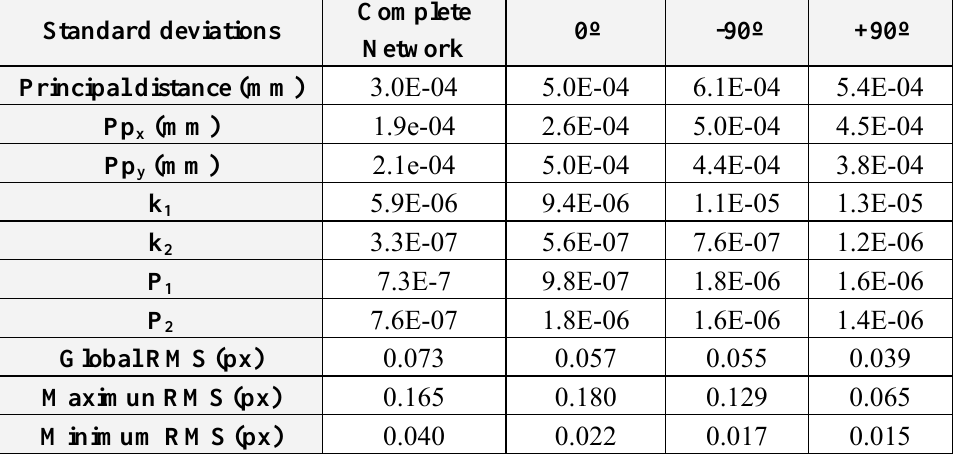
Table 7. Standard deviations obtained with the different